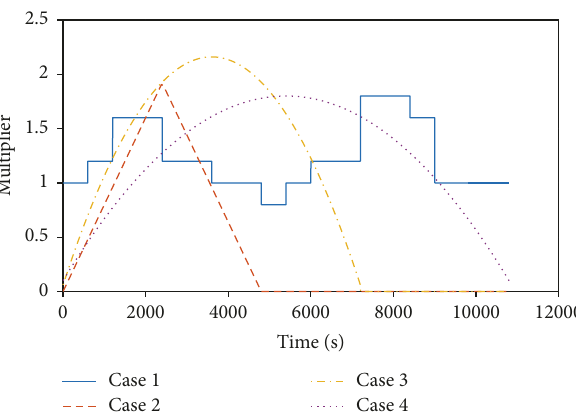
Figure 6: Passenger demand distributions in different